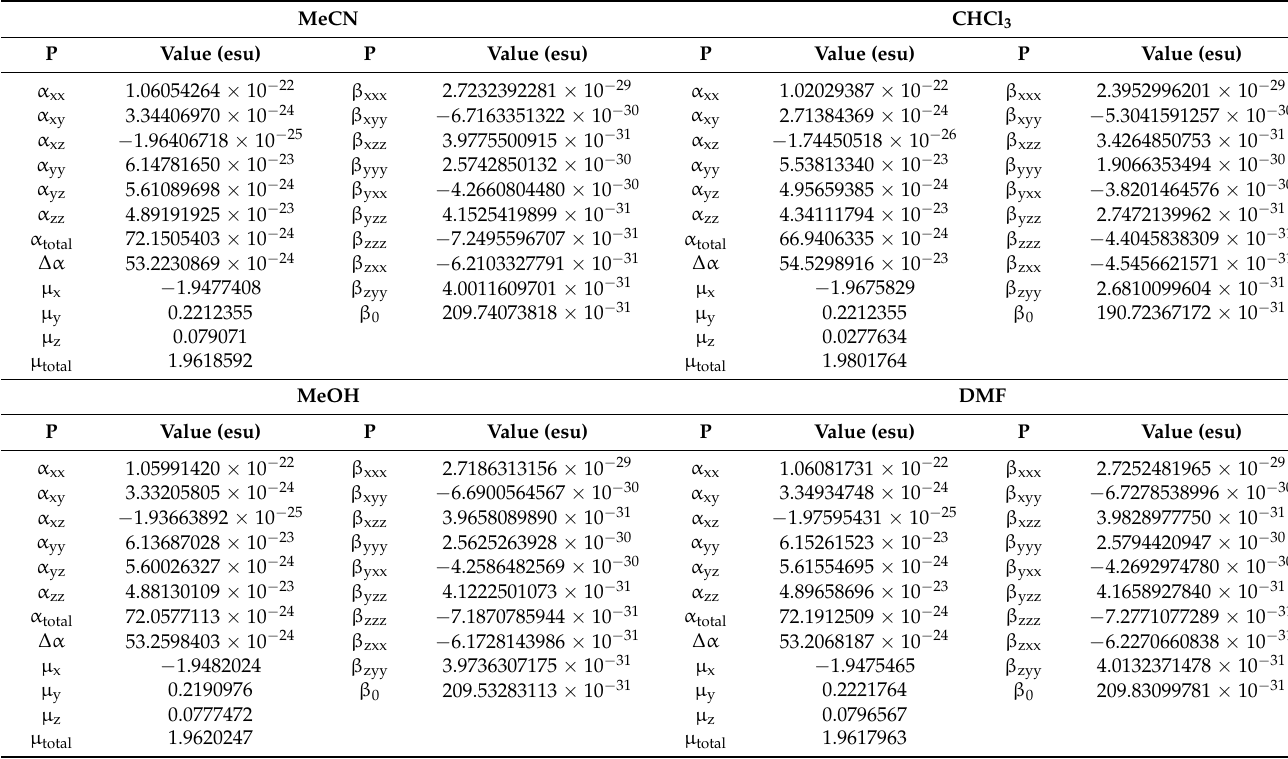
Table 6. The electric dipole moment, polarizability, and first-order hyperpolarizability values of 2 in different solvents.